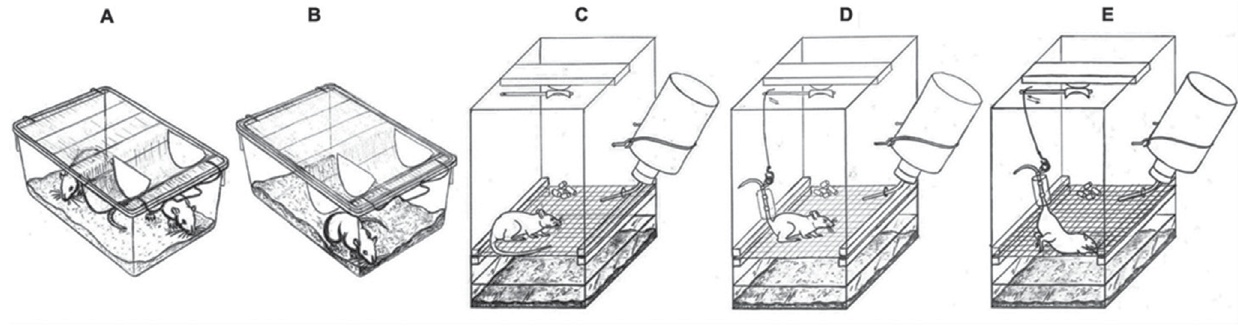
Figure 1. Design of the experimental cages. Control ( A ), isolated-control ( B ), isolated ( C ), attached ( D ), and unloaded ( E ) rats.